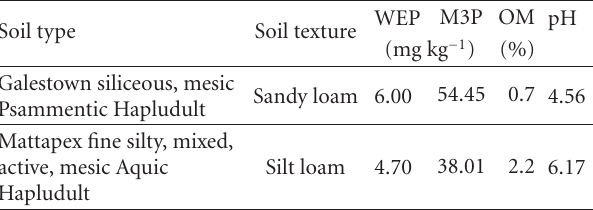
Table 1: Baseline water extractable phosphorus (WEP), Mehlich-3 phosphorus (M3P), organic matter (OM), and pH for each soil after 14-day preincubation at 25 ◦ C, but prior to amendment.